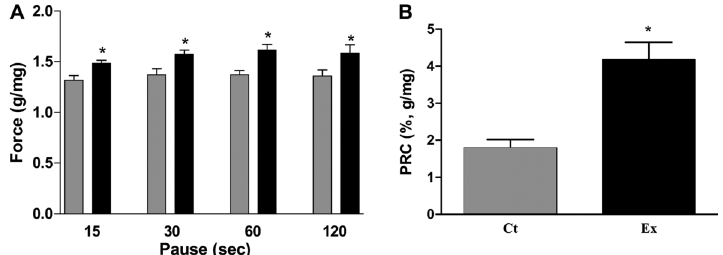
Figure 4. Effects of post-rest potentiation ( A ) and post-rest contraction (PRC) ( B ) on force devel- oped in isolated left ventricle papillary muscles from control (Ct, n=16) and exercised (Ex, n=16) spontaneously hypertensive rats (SHR). Gray bars: control; black bars: exercise. Results are